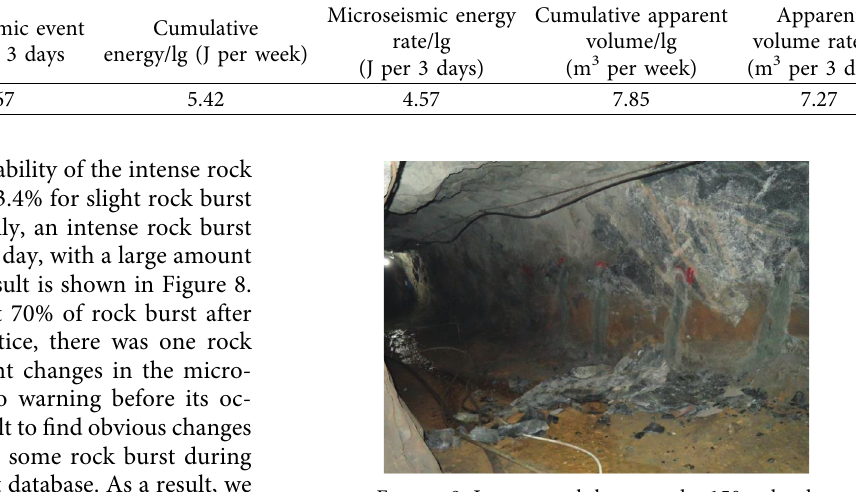
Table 4: Microseismic parameters in a spatial waning unit.